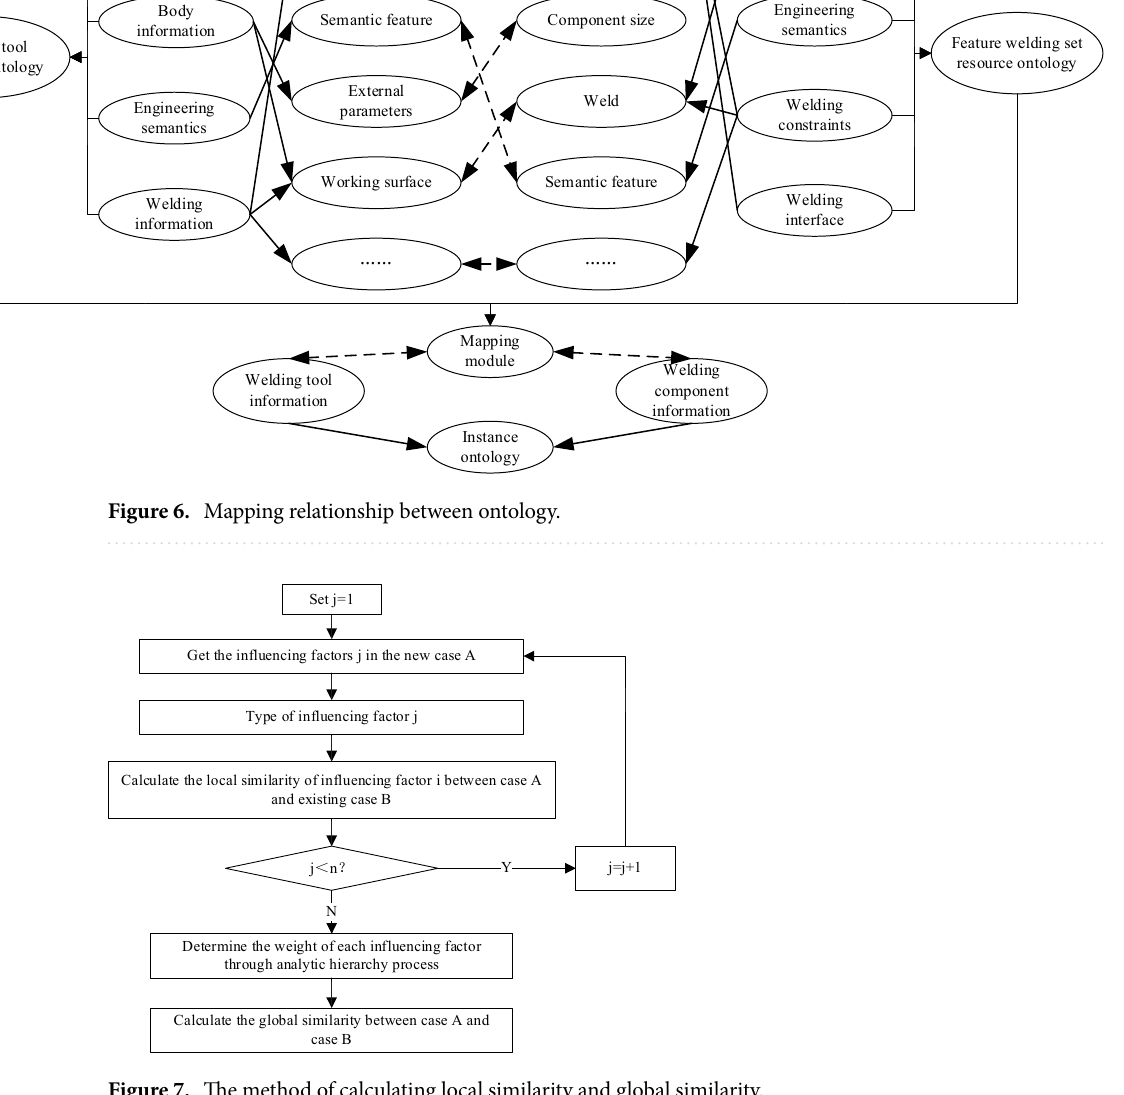
Figure 7. The method of calculating local similarity and global